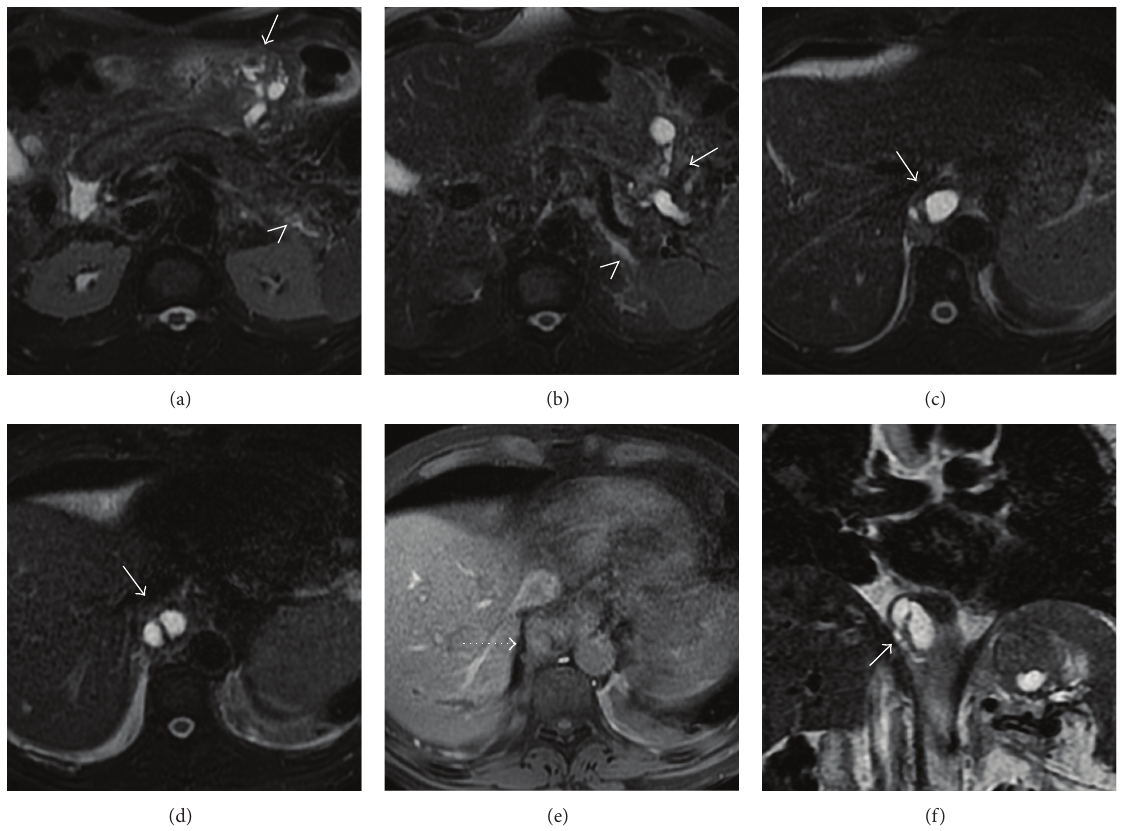
Figure 2: ((a)–(d)) On T2-weighted fat saturated MRI, the fluid collections appear as discrete areas of homogeneous hyperintensity extending from the abdominal cavity to the mediastinum. (e) On T2-weighted fat saturated MRI, the fluid collections are slightly isointense, finding suggestive for proteinaceous or necrotic contents. (f) Coronal T2-weighted MRI image shows the fluid collections extending upward as a long vertical cystic lesion from the retroperitoneum to the mediastinum through the esophageal hiatus.